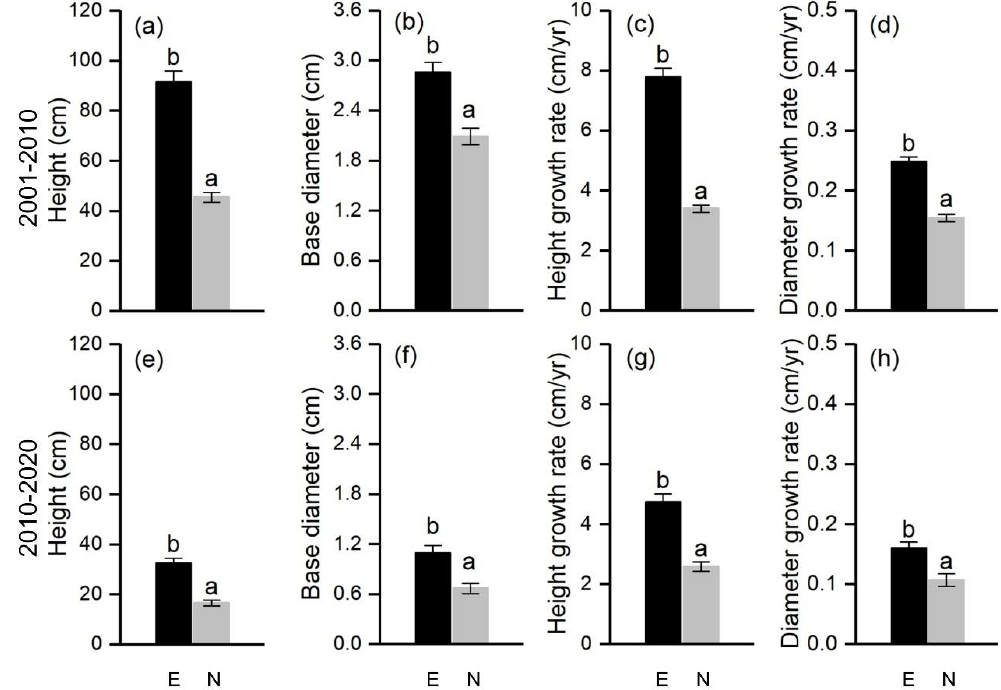
Figure 4. Height ( a , e ), base diameter ( b , f ), height growth rate ( c , g ), and diameter growth rate ( d , h ) of Balfour spruce during 2001 – 2010 (upper panels) and 2010 – 2020 (bottom panels) on the north- and east-facing slopes. Different letters indicate significant differences at p < 0.05.